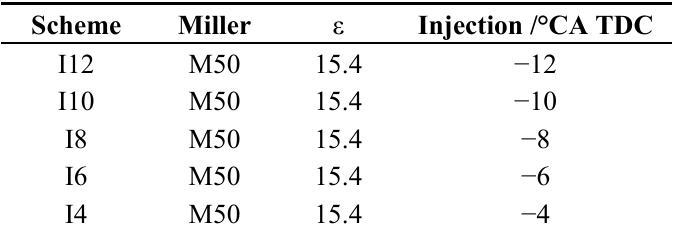
Table 5. High ε Miller cycle with different injection times.